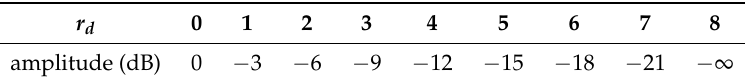
Table 2. Amplitude of each drawbar r d , d ∈ [ 1 · · · 9 ]